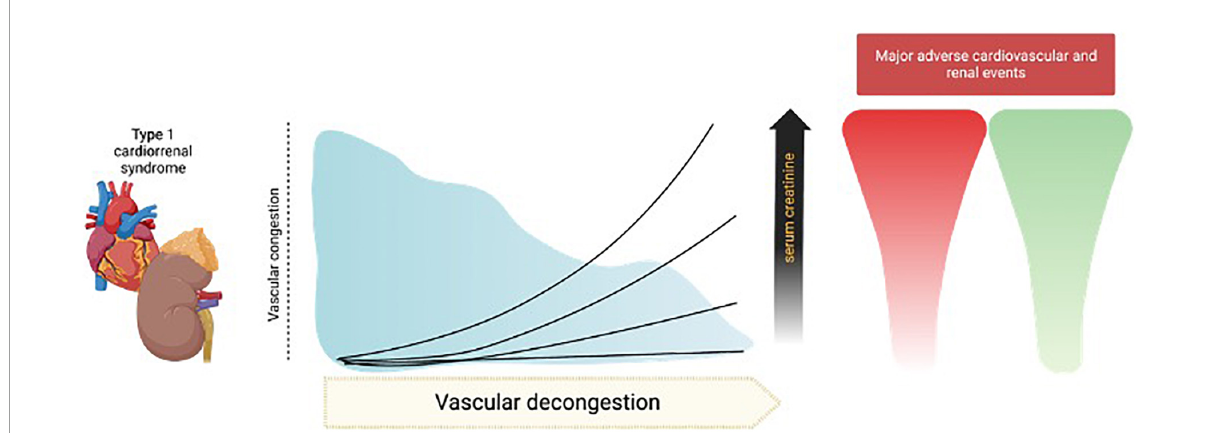
FIGURE1 Causes of increase in serum creatinine (sCr) during decongestion. Hypotheses that are unlikely to play a critical role, such as ischemic damage that induces acute tubular necrosis and sCr hemoconcentration, are described in the panel (left) . In the panel (right) , the theories that are more likely and would have more prominence during the appearance of this event such as renal hypoperfusion, the induction of true intravascular hypovolemia and neurohormonal activation with hemodynamic alteration of the afferent and efferent glomerular arteries. The image was licensed from